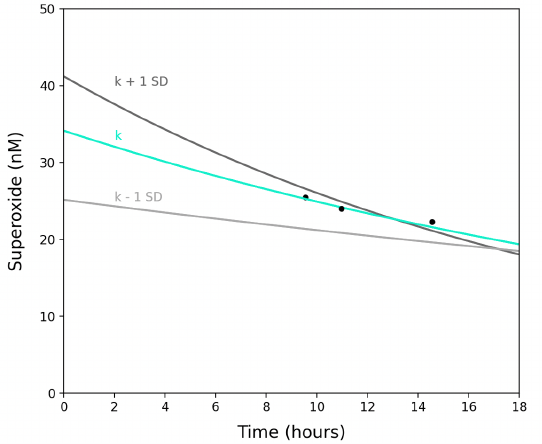
Figure 3. A model of the instantaneous O – 2 concentration produced by a diluted 100 µM SOTS- 1 solution as a function of time. The turquoise line gives the evolution of O – 2 produced by the thermal degradation of SOTS-1 for a decay constant at 10°C. The gray lines depict the impact of the uncertainty (±1 SD) in the degradation constant. The black points show O – 2 concentrations estimated from independent KO 2